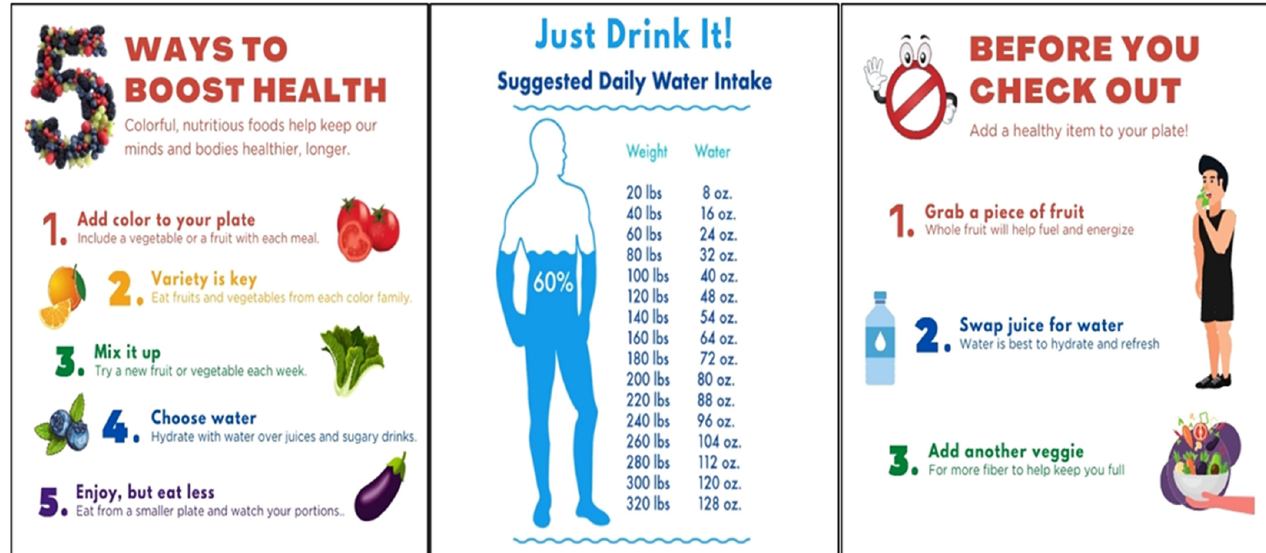
Figure 2. Healthy eating infographics the user would see if they clicked into the Bluetooth beacon push notifications they received while in the interactive food purchasing environment.